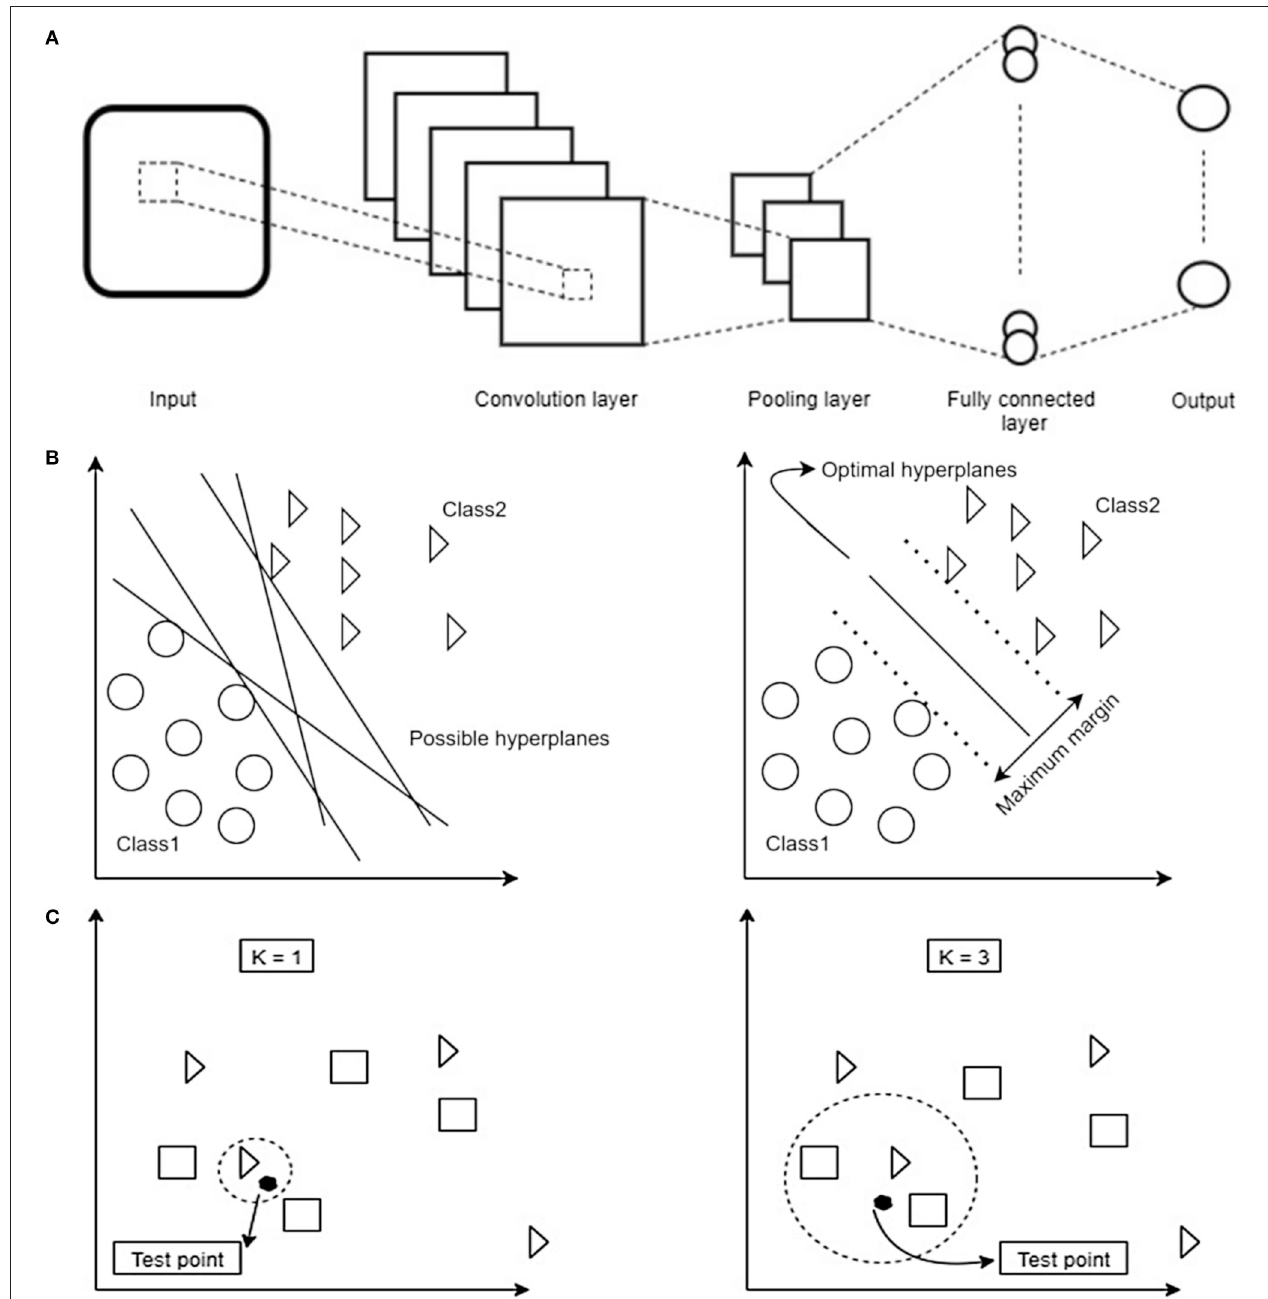
FIGURE 2 | (A) Schematic overview of the dataflow in a Convolutional Neural Network (CNN). Image data is fed into the network as an input. In order to reduce the data dimensionality, different convolution and pooling layers are used. Finally, to have the classification, fully connected layer is used to flatten the output of the previous layer. (B) Schematic overview of how a Support Vector Machine (SVM) selects the best hyperplane for classification. First hyperplanes are calculated which are able to optimally separate data points. From all possible hyperplanes, the algorithm chooses the optimal one maximizing the distance between the hyperplane and the points of two classes. Note that in 2D the hyperplane corresponds to a line. Based on the kernel function chosen this can have different shapes. (C) Schematic overview of decision boundaries in a K-Nearest Neighbors (KNN). Distance between test- and training data points are calculated. Afterwards, based on the value of K, the algorithm decides which class a given test point belongs to (in the example being a triangle or a square). Depending on the value of K different classification results are possible: on the left the test point would be classified as a triangle, on the right as a